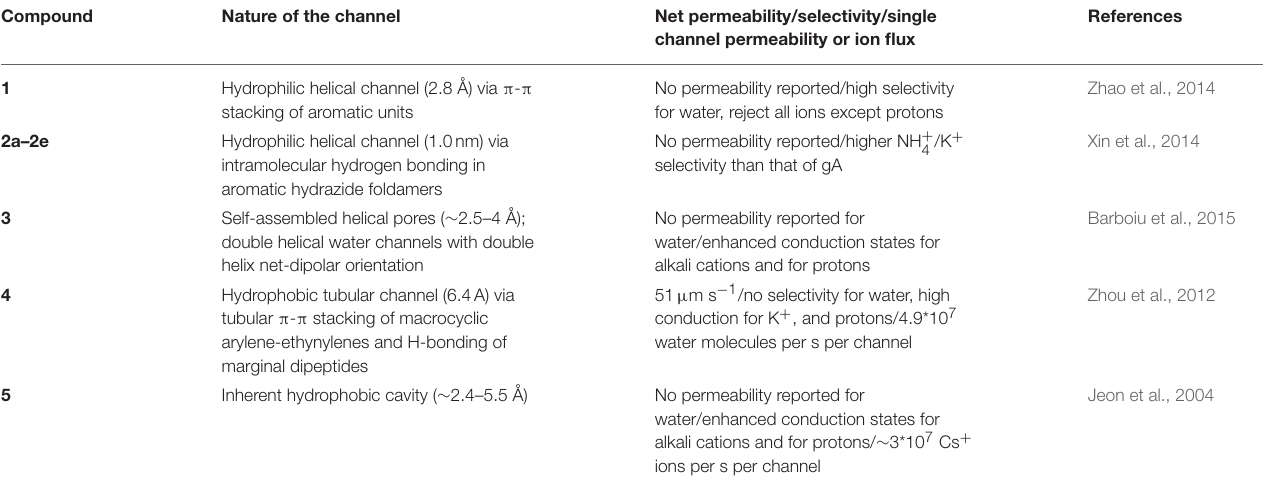
TABLE 1 | A summary of various artificial gA channels.